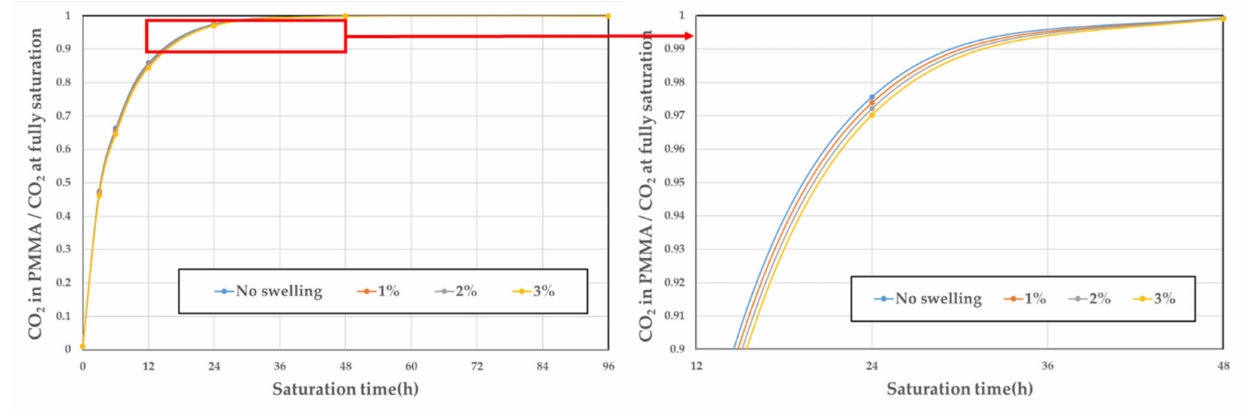
Figure 8. Sorption curves relative to the change in thickness using the same diffusion